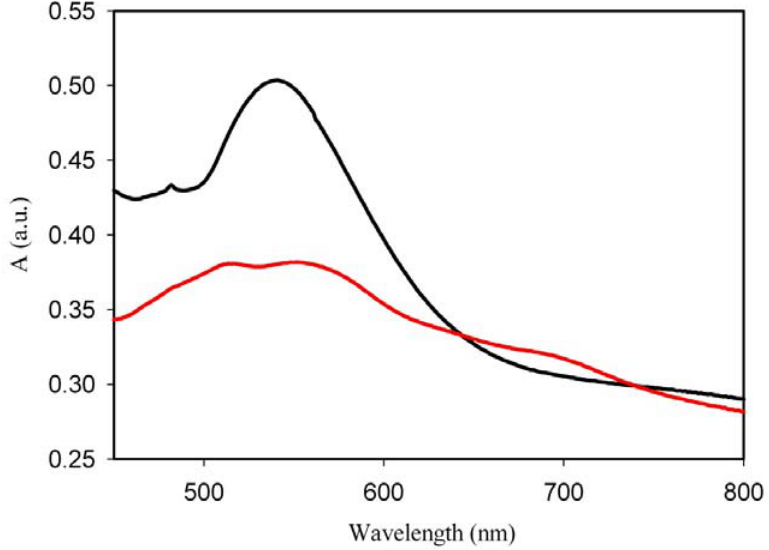
Figure 5. UV-Vis spectra corresponding to the thermo-reduced samples ( − the spin-coated sample is annealed after 30 min after the deposition, − the sample is annealed